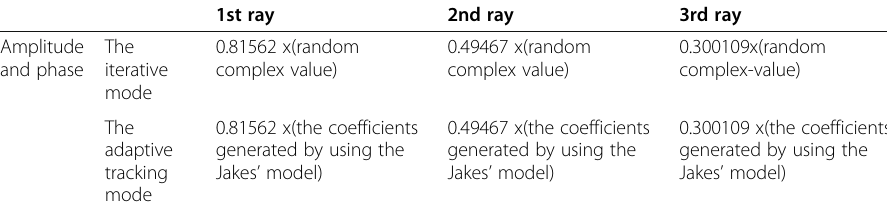
Table 3 Multipath delay profile